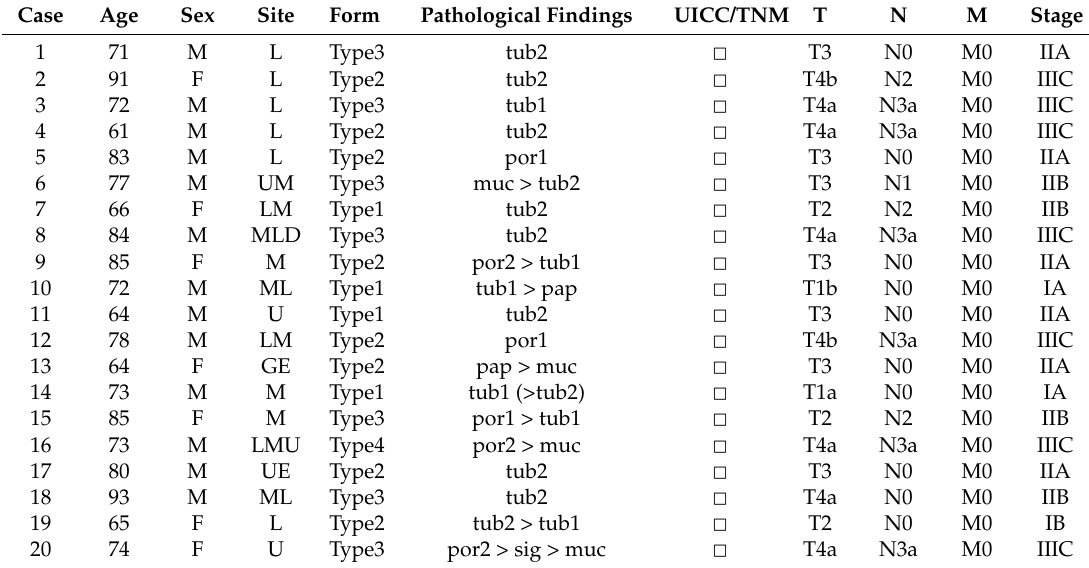
Table 1. Patient